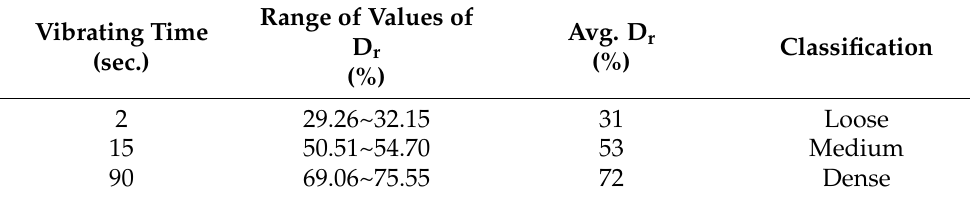
Figure 3. Grain size distribution curve for Hapcheon sand. Table 4. Relative density in test